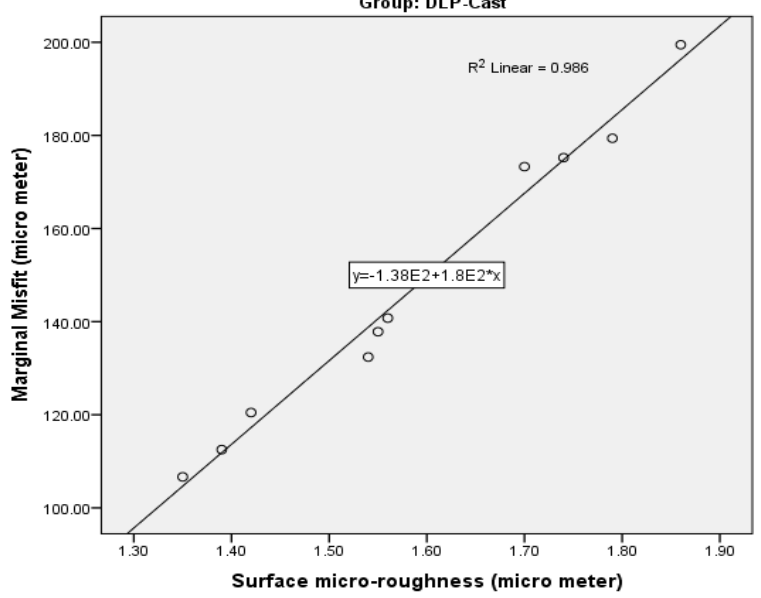
Figure 6. Showing a positive correlation between surface micro roughness and marginal misfit in SLM samples. R 2 showed 94.8% variation in marginal misfit explained by surface micro roughness; p -value was less than 0.01, and therefore statistically significant.